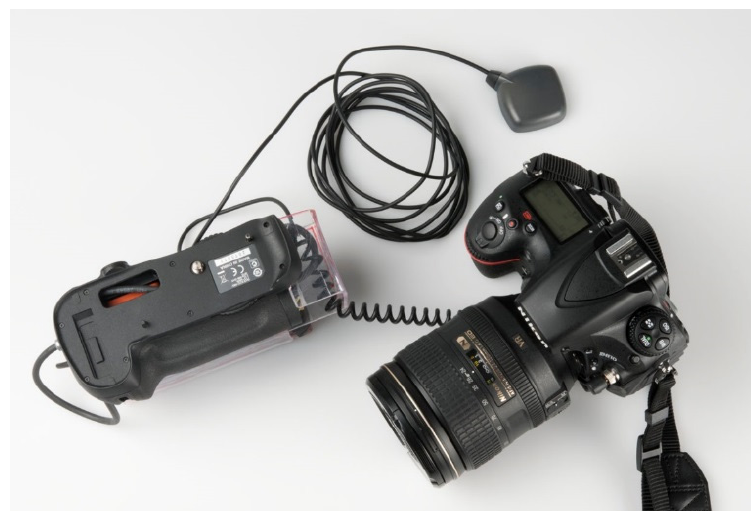
Figure 3. A Nikon D810 with the detached battery grip, which houses the GPS/INS and logging hardware. The GNSS antenna (square device in the upper right area) is connected with a 2 m-long cable with the logging hardware. The spiral flash sync cord connects the camera and logging hardware (photo: G. Gattinger).